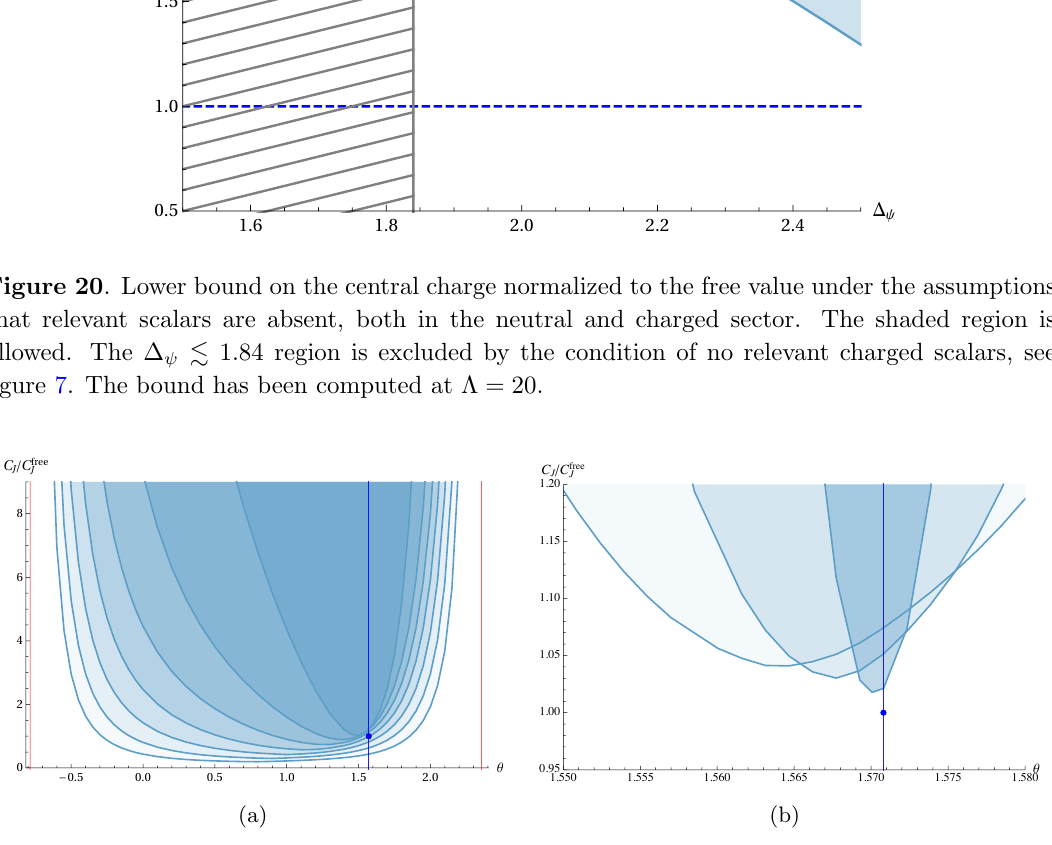
Figure 21 . Left: lower bound on the global symmetry current central charge C J , normalized to the free value, as a function of the parameter (cid:18) de(cid:12)ned in (2.27). The shaded regions are allowed. Di(cid:11)erent shadings correspond (from darker to lighter) to (cid:1) = 1 : 6 ; 1 : 7 ; 1 : 8 ; 1 : 9 ; 2 : 0 ; 2 : 1 ; 2 : 2. Vertical red lines indicate the extremes of the (cid:18) parameter (cid:0) (cid:25)= 4 and 3 (cid:25)= 4. The blue vertical line indicates the value (cid:18) = (cid:25)= 2. The blue dot on this line corresponds to the free fermion theory. The bounds have been computed at (cid:3) = 16. Right: same plots zoomed aroung (cid:18) = (cid:25)= 2, with di(cid:11)erent shading corresponding (from darker to lighter) to (cid:1) = 1 : 501 ; 1 : 505 ; 1 :